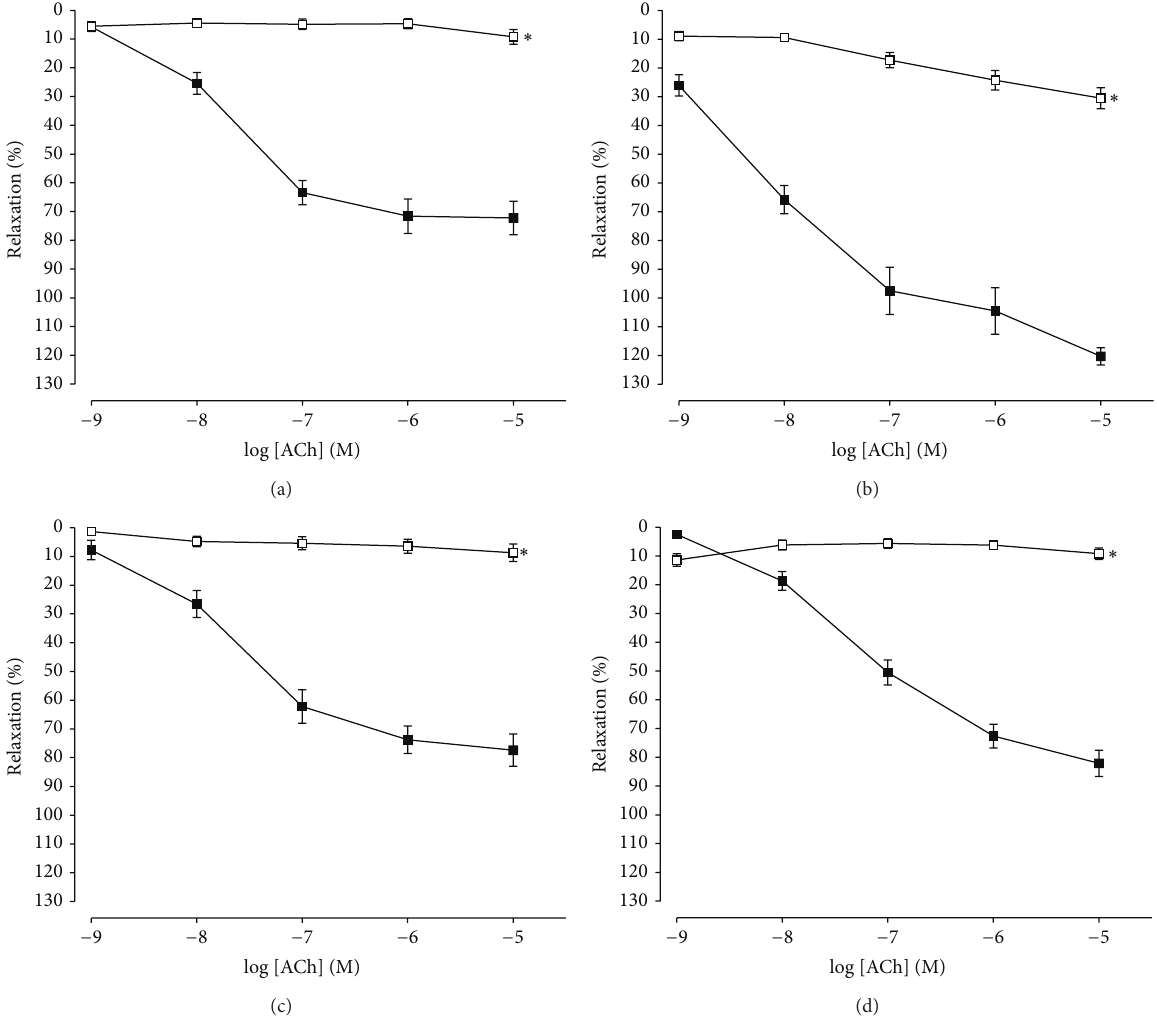
Figure 3: ACh-induced relaxation responses of aortic rings precontracted with PE (1 𝜇 M) in the presence of L-NAME (100 𝜇 M) in control (vehicle) (a), losartan (10mg/kg) (b), WOS (1000mg/kg) (c), and WMOS (1000mg/kg) (d). Responses to ACh are expressed as percentage of relaxation. Values are mean ± SEM of 5 to 6SHRs in each group. ∗ Denotes 𝑃 < 0.05 compared to ACh without L-NAME ( ◼